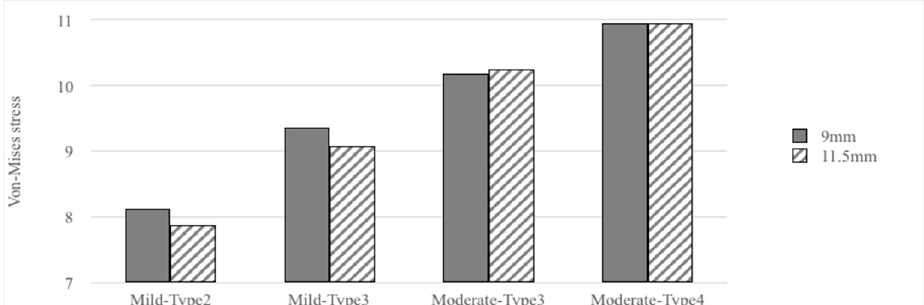
Figure 5. Peak values of von-Mises stresses in the cortical bone in loading condition A.